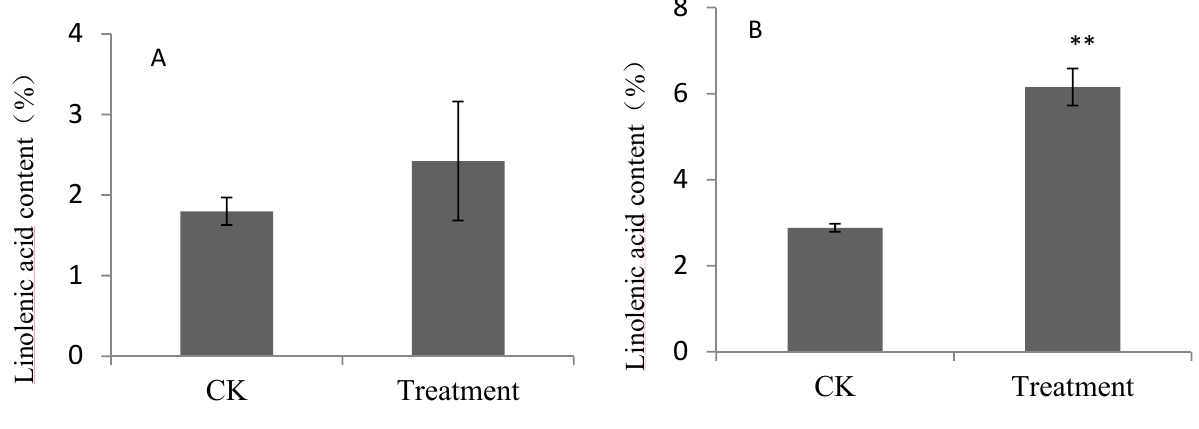
Figure 2. Linolenic acid contents of pear fruits feeding on linolenic acid. ( A ) P. bretschnrideri “Dangshansuli”; ( B ) P. ussuriensis “Nanguoli”; Values represented means of three replicates, bar were standard deviation; ** denoted significant difference between treatments and CK, p <